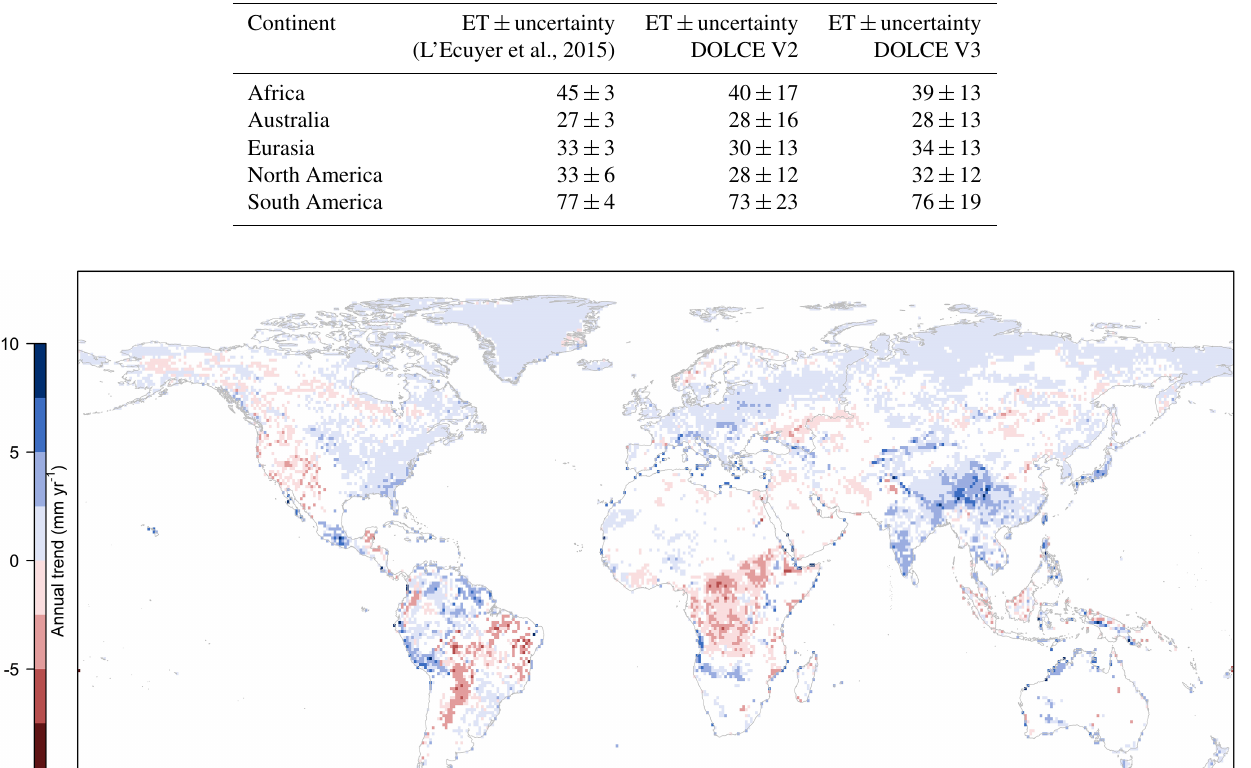
Table 3. Annual continental averages of ET (Wm − 2 ) and its standard deviation uncertainty calculated for DOLCE V2, DOLCE V3 and that developed in L’Ecuyer et al. (2015) over a common period 2000–2009. In L’Ecuyer et al. (2015), ET is derived by merging three global datasets and then adjusted by enforcing the physical constraints of the surface and atmospheric water and energy budgets.